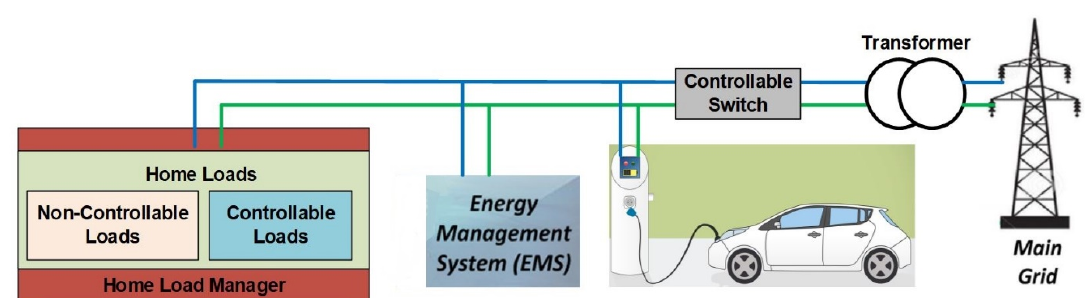
Figure 5. Block diagram of the V2H structure [36] .